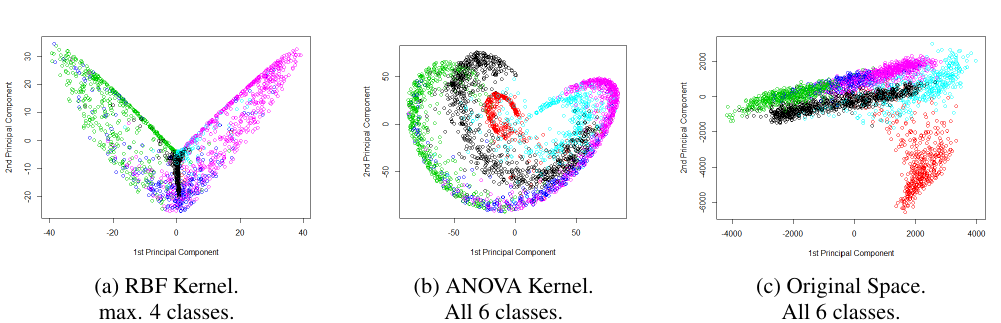
Fig. 4 Random project methods for kernel learning: PCA of stream data taken from four Statlog channels to detect six soil types. Soil types are separated using higher-order statistical properties in (a),(b) and (c). (a and b) are higher-order statistics while (c) are present in the original dataset. The hyperplane boundaries in (a) are able to separate all the six classes while in (b) a maximum of five are uniquely